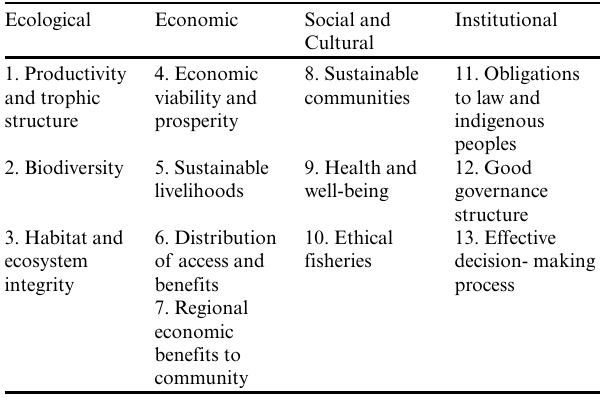
Table 2 . Canadian Fisheries Research Network framework elements of operational candidate objectives (Stephenson et al.